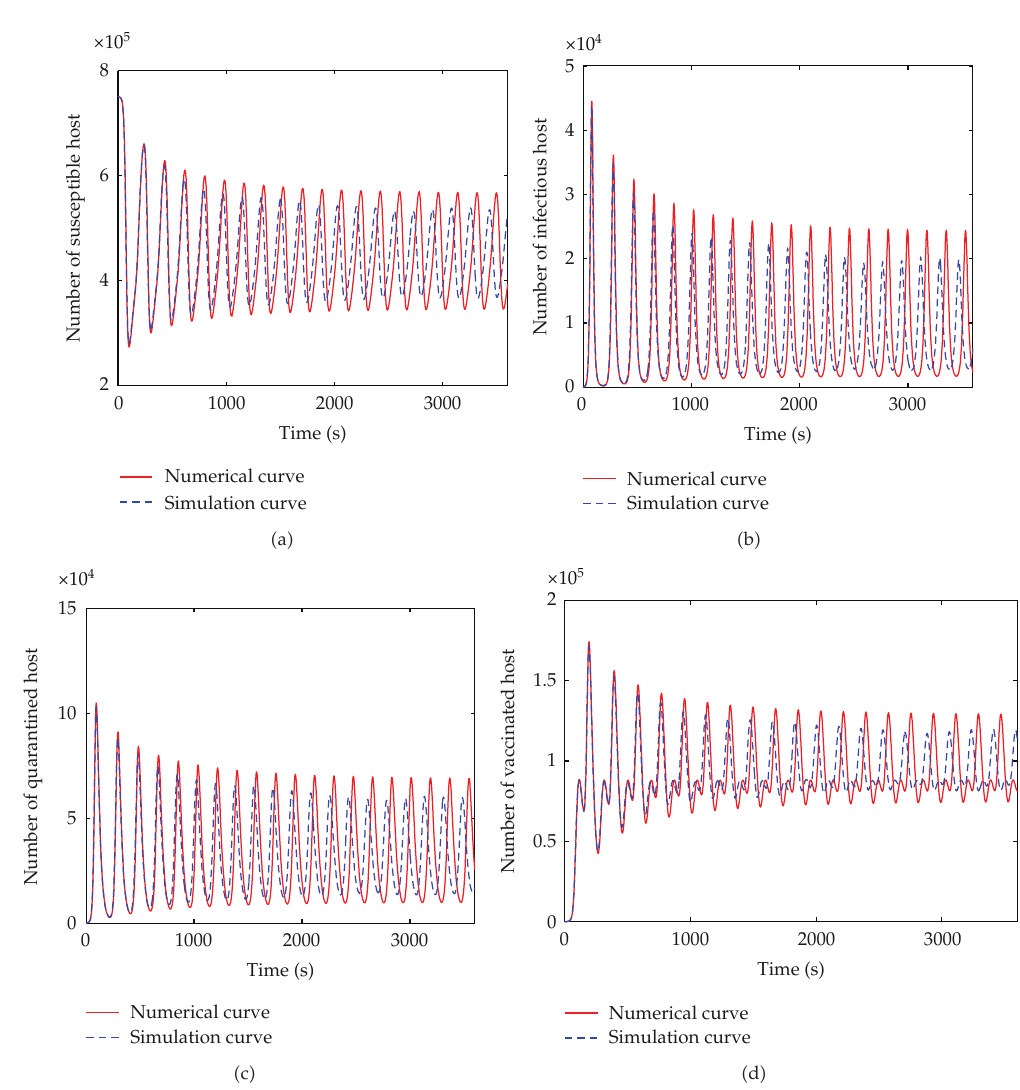
Figure 12: Comparisons between numerical and simulation curves of SEIDQV model when τ > τ 0